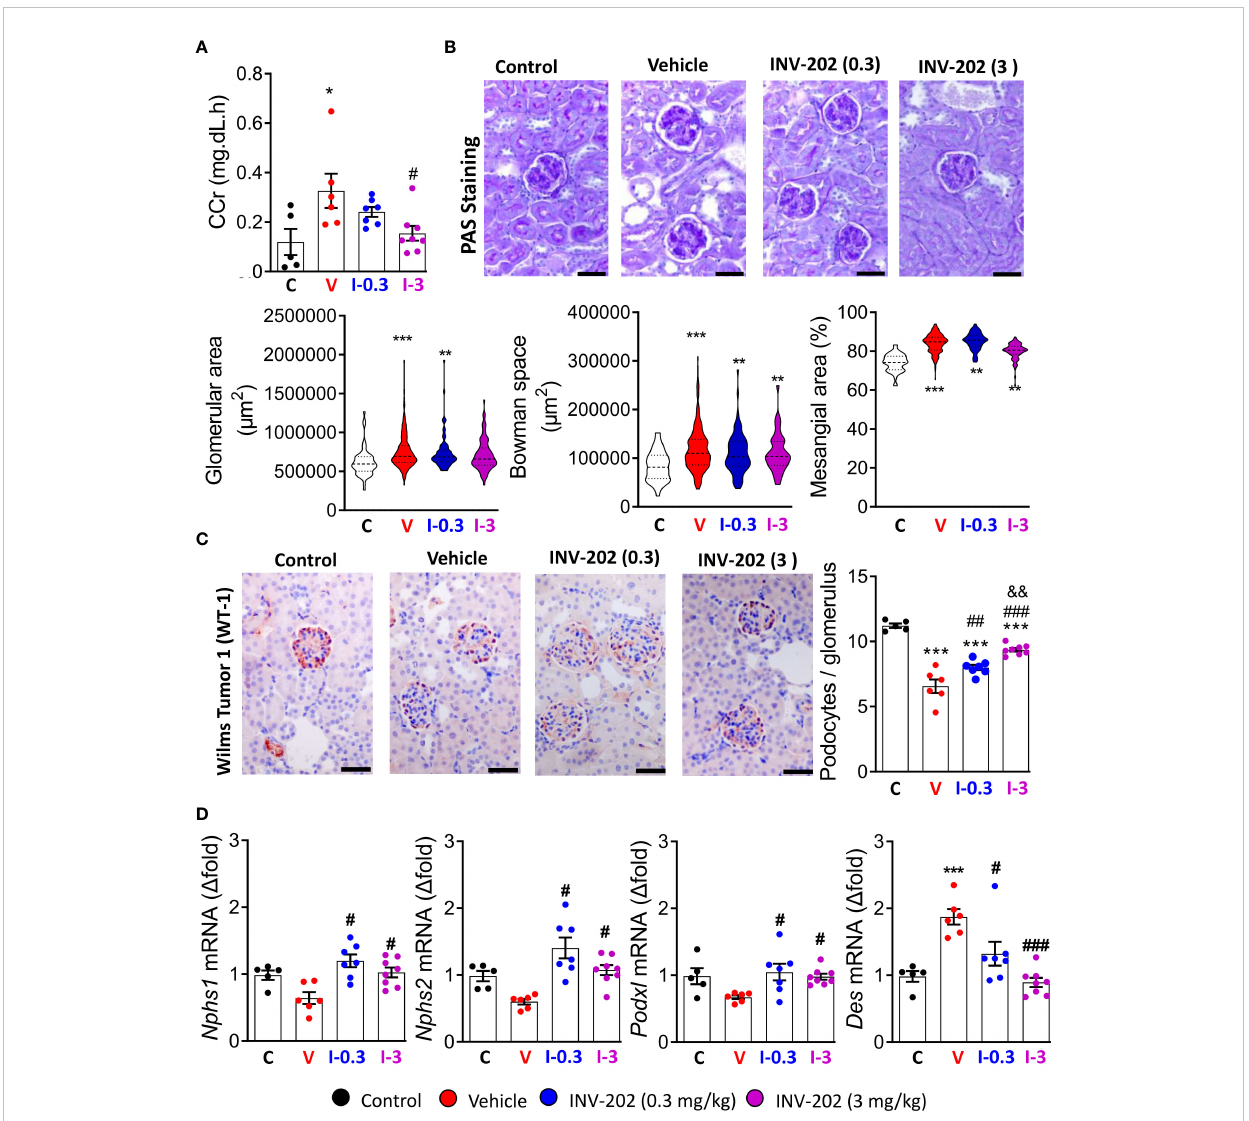
FIGURE 4 Effects of INV-202 treatment on glomeruli. (A) Summary of calculated CCrs. (B) Representative PAS staining performed on histological sections of kidneys from mice. Graphs summarize the mean glomerular area, Bowman space, and mesangial area (scale: 50 µm). (C) Representative immunostaining for Wilms tumor-1 protein (scale: 50 µm) with analysis of the mean podocyte numbers per glomerulus cross-section. (D) Nphs1 , Nphs2 , Podxl , and Des mRNA expression coding for nephrin, podocin, podocalyxin, and desmin, respectively. Statistical signi fi cance versus nondiabetic control: *p < 0.05; **p < 0.01; ***p < 0.001; versus vehicle: #p < 0.05; ##p < 0.01; ###p < 0.001; versus INV-202 group, 0.3 mg/kg: &p < 0.05; &&p < 0.01. CCr, creatinine clearance; PAS, periodic acid-Schiff. C: non-diabetic control mice, V: Vehicle-treated diabetic mice, I-0.3: INV-202-treated diabetic mice (0.3 mg/kg), I-3: INV-202-treated diabetic mice (3